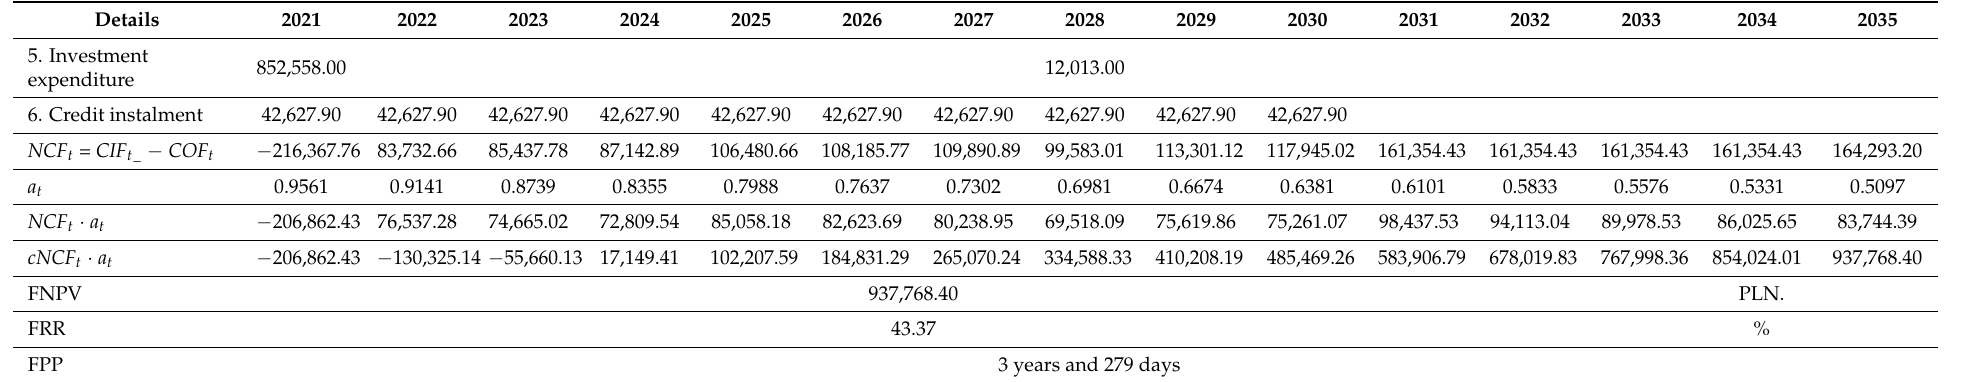
Table 20. Assessment of the financial effects of the project, taking into account changes in the shaping of risk factors. Source: designed by authors. Risk